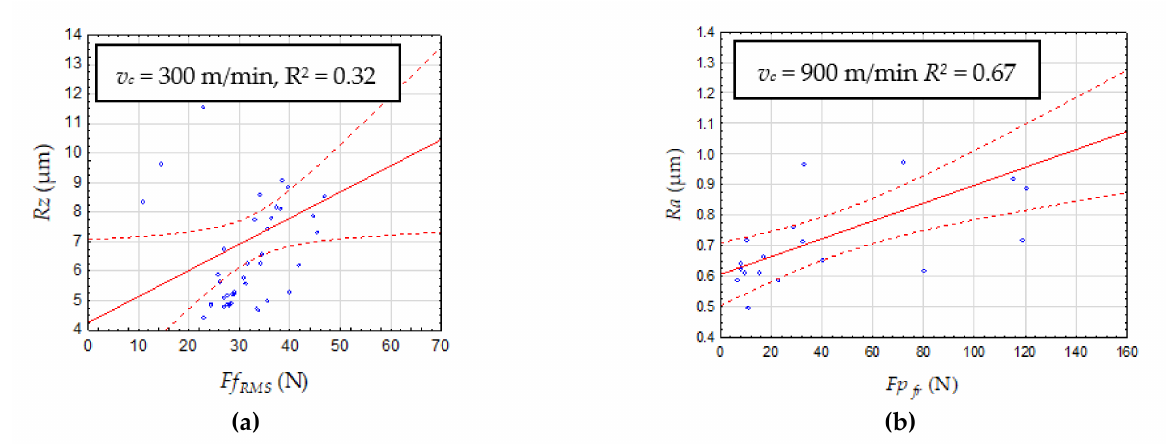
Figure 10. Surface roughness parameter as a function of cutting force measures ( a ) time domain, Ff RMS , ( b ) frequency domain Fp fr .